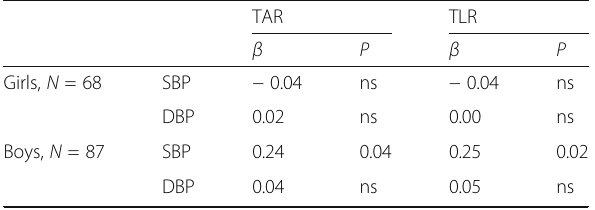
Table 5 Relationships between fat distribution at baseline and blood pressure at follow-up TAR TLR